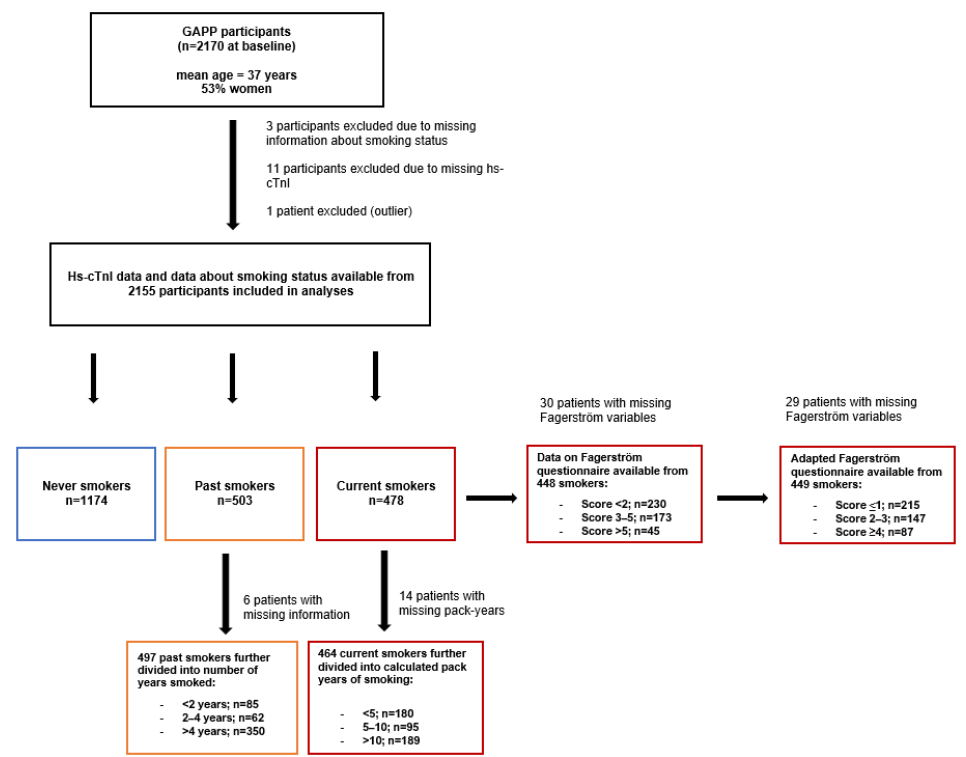
Figure 1. Flowchart of troponin and smoking data.